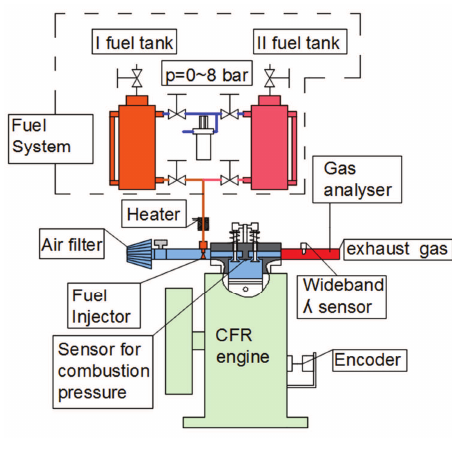
Fig. 3. Scheme of research test stand